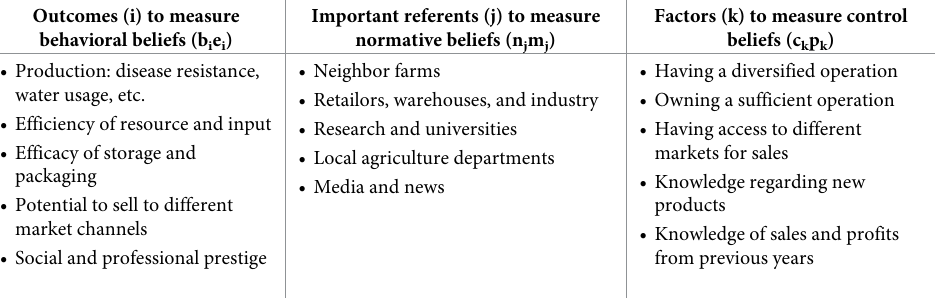
Table 2. Perceived outcomes (i), important referents(j), and control factors(k) identified in semi-structured